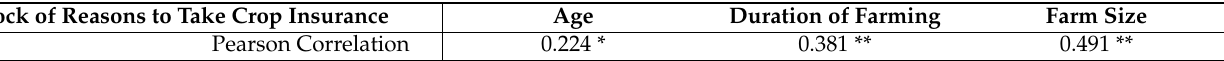
Table 1. Statistical relationships between reasons for crop insurance and farmers’ age, farm size, and length of farming. Block of Reasons to Take Crop